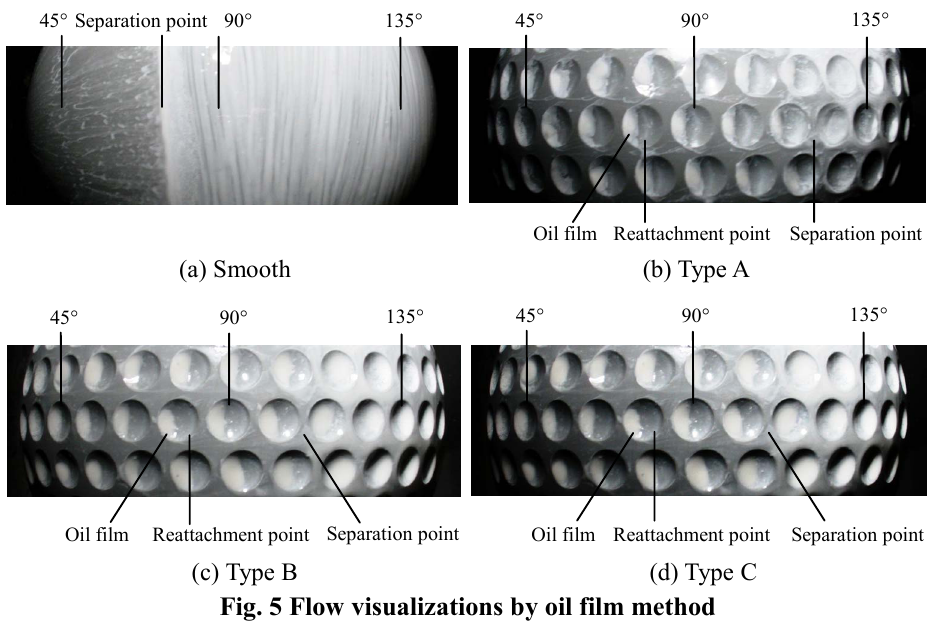
Fig. 5 Flow visualizations by oil film